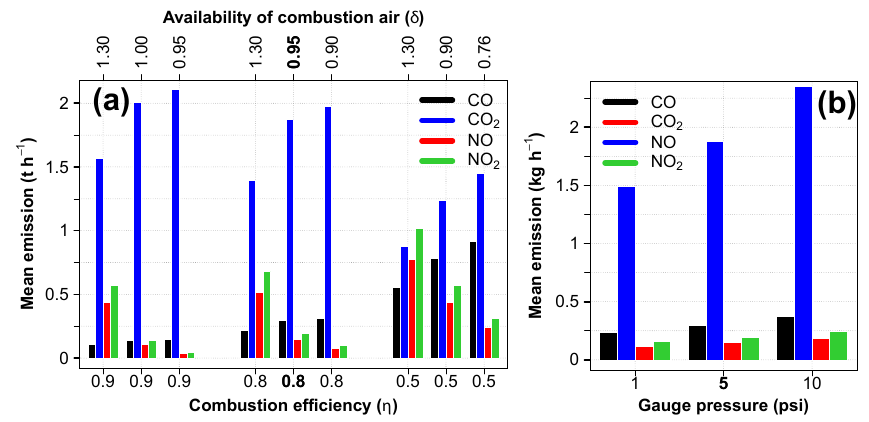
Figure 8. Flaring emissions (th − 1 ) spatiotemporally averaged over SWA and TP15 depending on (a) combustion efficiency η and availability of combustion air δ for a gauge pressure of 5psi and (b) gauge pressure (psi) for η = 0 . 8 and δ = 0 . 95. SO 2 is not shown because it does not depend on η or δ .